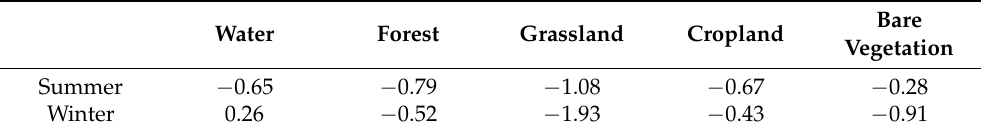
Figure 8. Comparison of AD-Net (red) and ECMWFs (blue) PBL in the case of different land cover types (water, forest, grassland, cropland, and bare vegetation) for summer ( a ) and winter ( b ). Table 3. Seasonal differences in BLH between AD-Net and ECMWFs (ECMWFs PBL minus AD-Net PBL) given different land cover conditions.